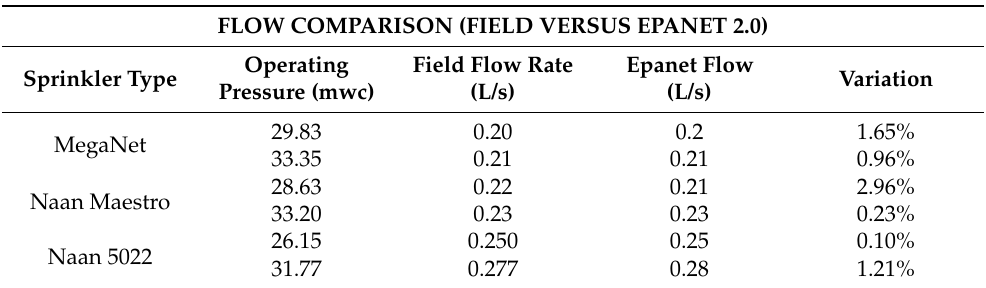
Table 4. Comparison of field measured and modelled discharge flow rates in Epanet 2.0 sprinklers. FLOW COMPARISON (FIELD VERSUS EPANET